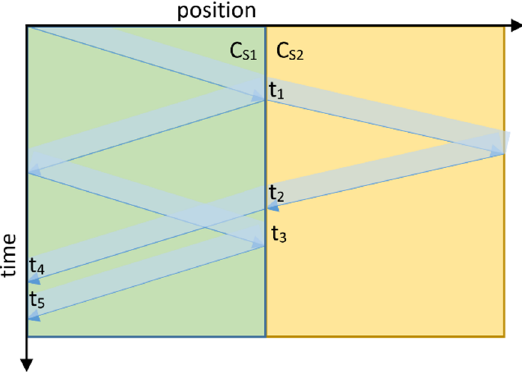
Figure 15. Timing diagram of the acoustic signals in the tubes. Green region marks common sound path and yellow marks sensing end. Blue shadow marks presence of acoustic signal at specific point in time and position.